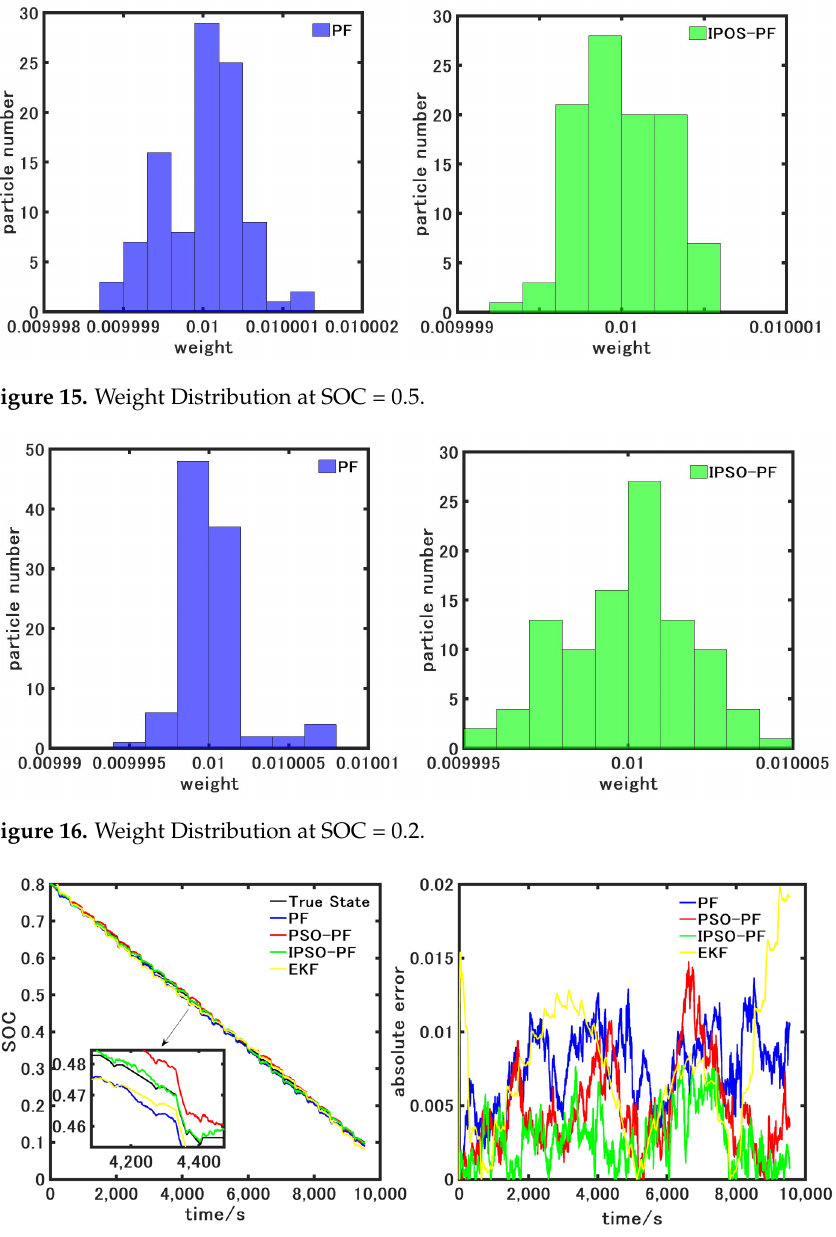
Figure 17. SOC Estimation Results and Errors of DST Driving Condition. Table 4. Errors of DST Driving Condition.